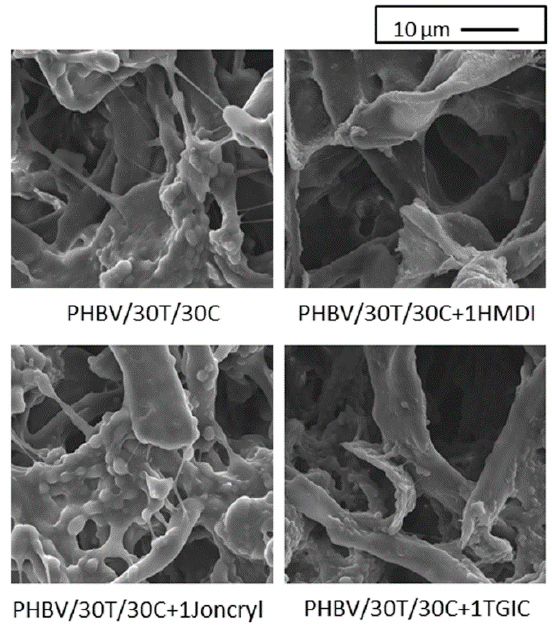
Figure 10. SEM micrographs of PHBV/30T/30C samples with and without 1 phr reactive agents after Soxhlet extraction.